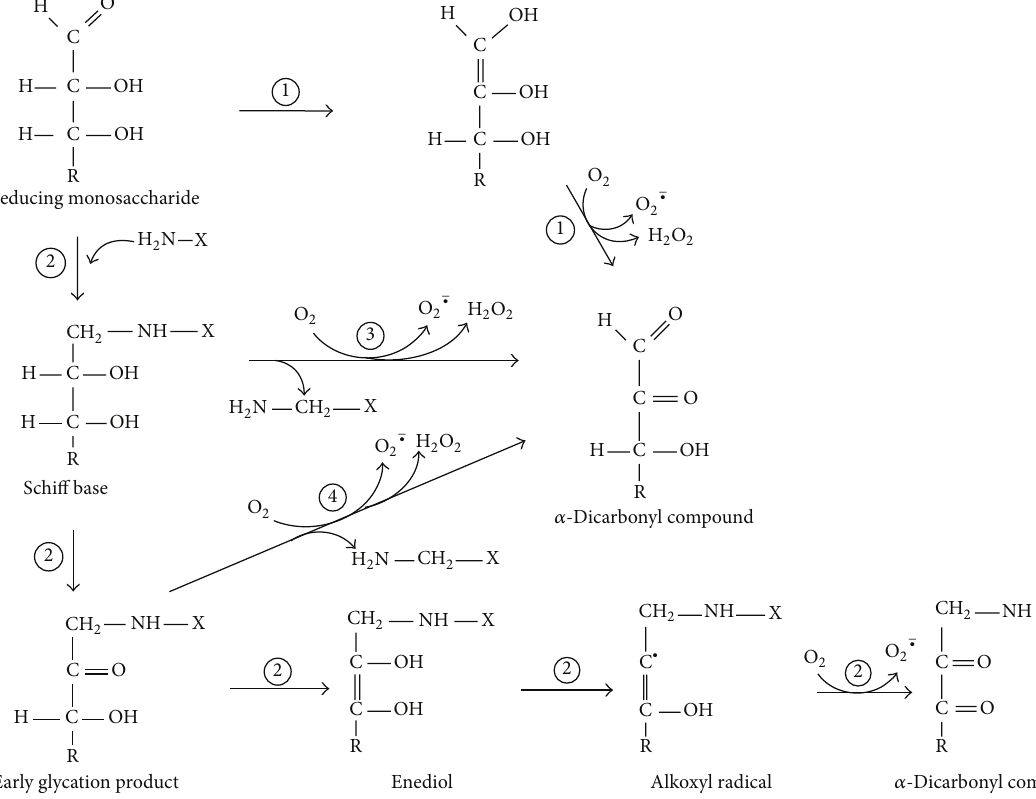
Figure 5: Involvement of reducing monosaccharides such as glucose and fructose in the glycoxidation reactions resulting in the production of ROS and RCS: (1) Wolff pathway; (2) glycation; (3) Namiki pathway; and (4) Hodge pathway.